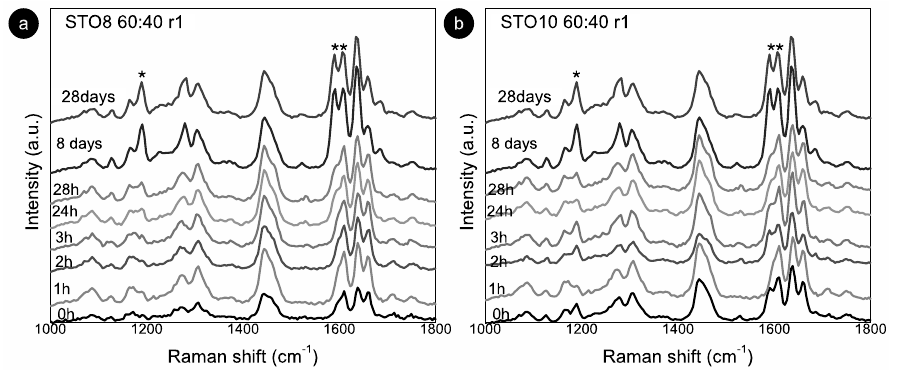
Figure 3. Room temperature Raman spectra for: ( a ) STO8 60:40-r1 and ( b ) STO10 60:40-r1. (*) and (**) represent modes at 1190 cm −1 and 1590 cm −1 respectively.